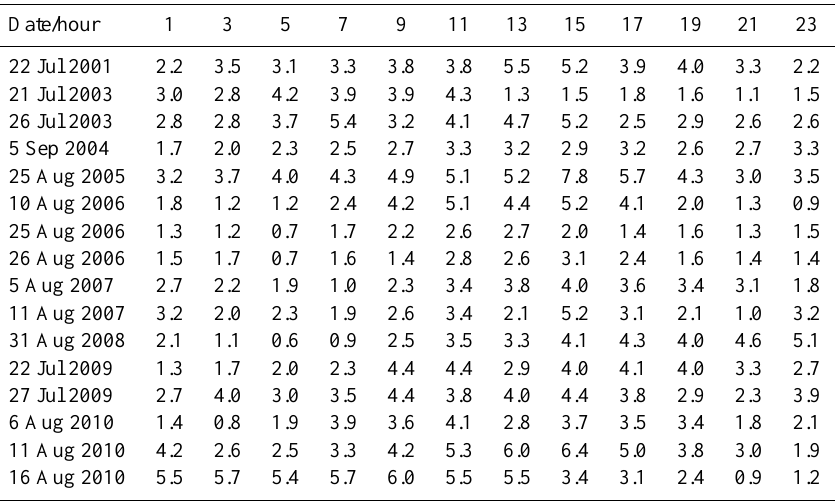
Table A3. Observed wind speed (ms − 1 ) on the days with episodes (above 100sporesm − 3 ) of fungal spores that were selected and presented in Table